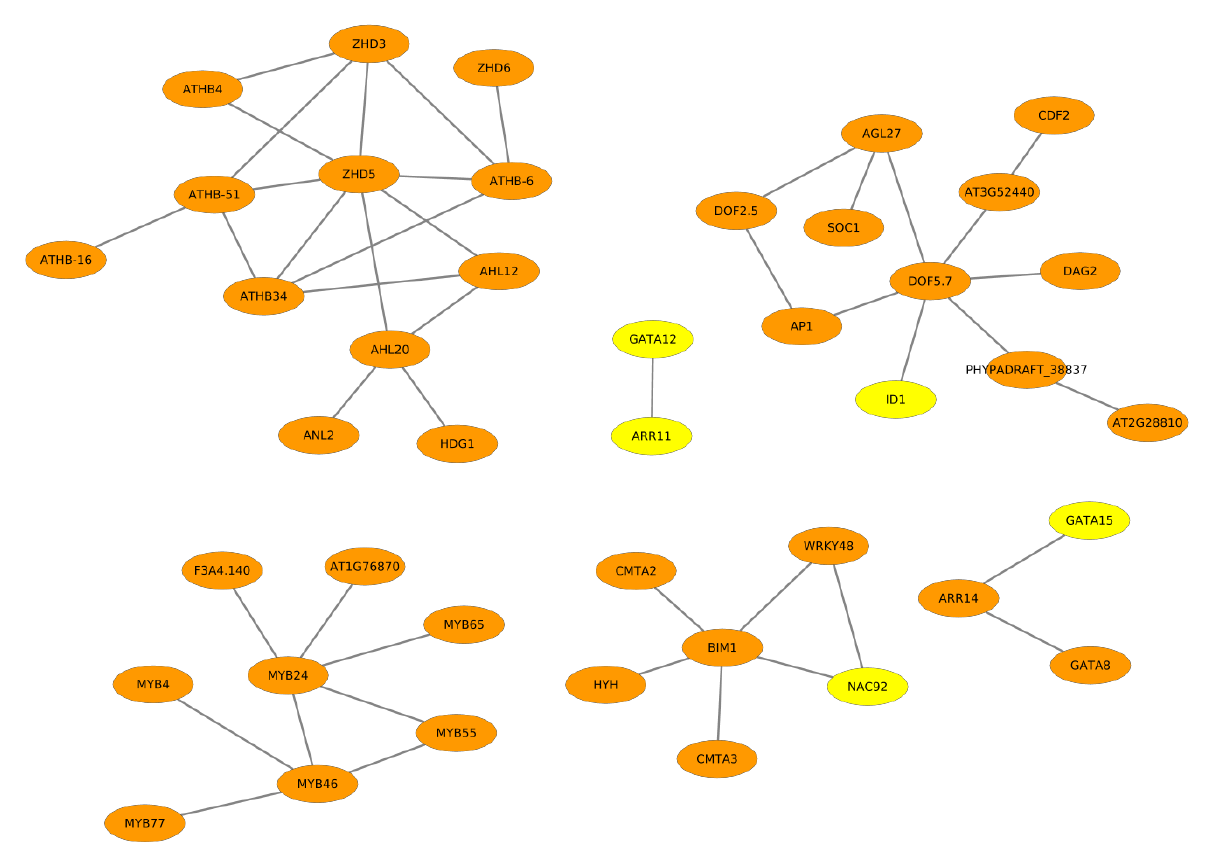
Figure 2. Cooperation network of TF pairs identified for the double low accession ZS11 cultivar. The orange shaded nodes represent the overlapping TFs between ZS11 and ZY821, whereas the yellow shaded nodes represent the TFs that are unique for the ZS11